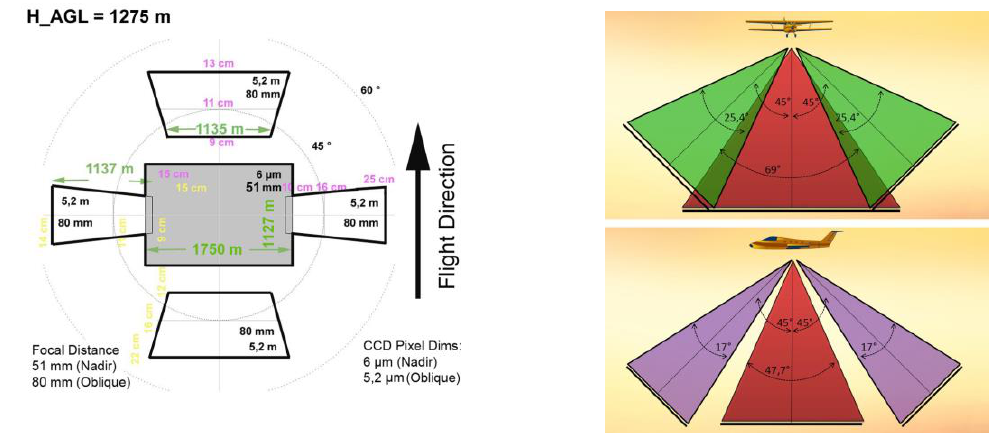
Figure 2: UltraCam Osprey footprint (left) and FOV diagram (right)